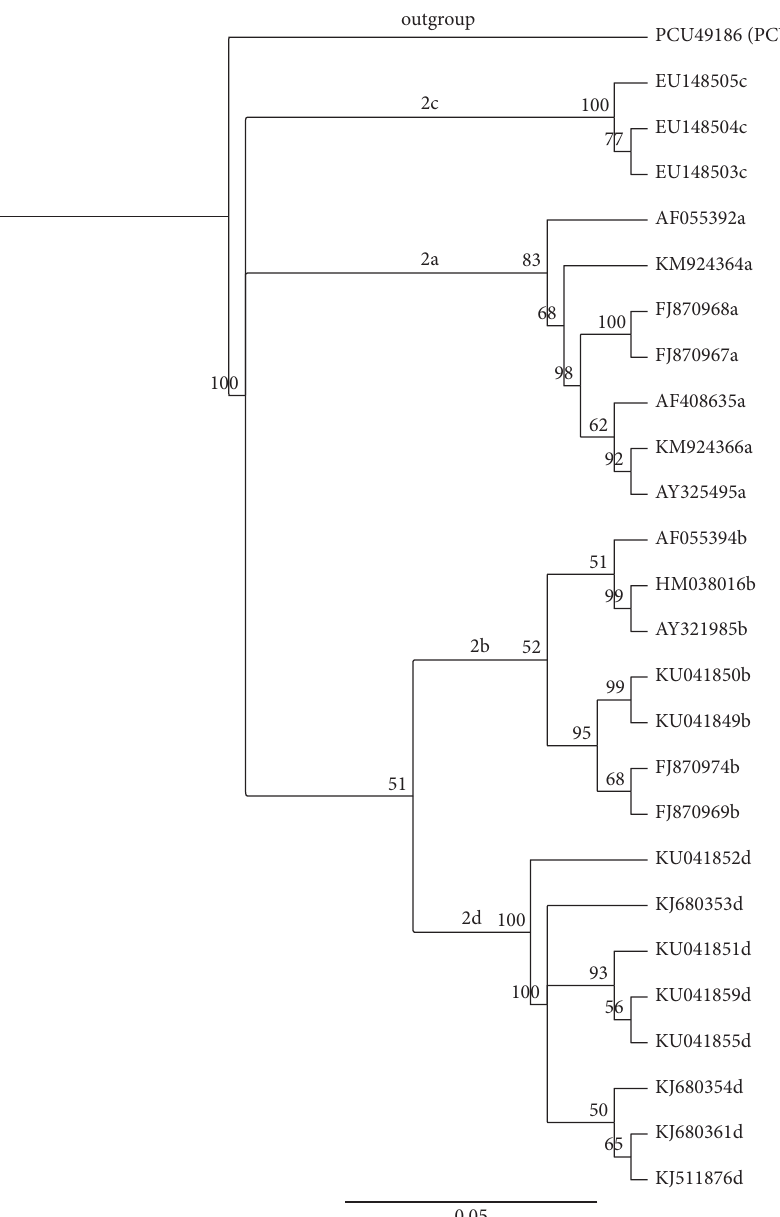
Figure 2: Four main genotypes of PCV2 as shown by phylogenetic tree that was constructed based on neighbor-joining method for complete genomes of some PCV2 sequences obtained from NCBI Genbank; genotypes of the virus were written on the main branches of the tree and PCV1 was used as outgroup (NB: the tree was constructed using Geneious 9.1.5, Biomatters Ltd. Boostrap values obtained from 1000 replicates are shown at the major